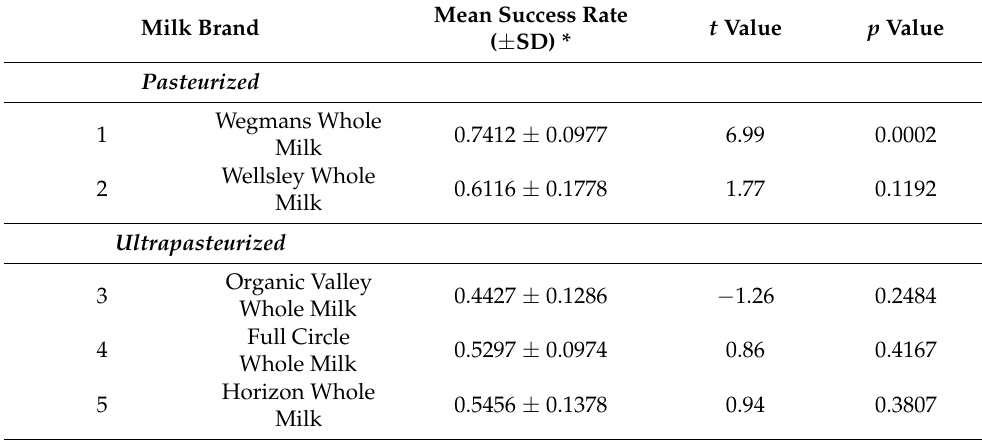
Table 2. Mean success rate in identifying pasteurized and ultrapasteurized samples for each milk brand. Mean Success Rate t Value p Value Milk Brand ( ± SD) * Pasteurized Wegmans Whole Milk